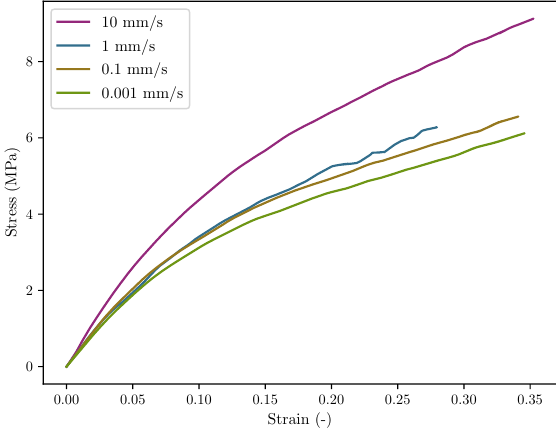
Figure 2. Bulk Material